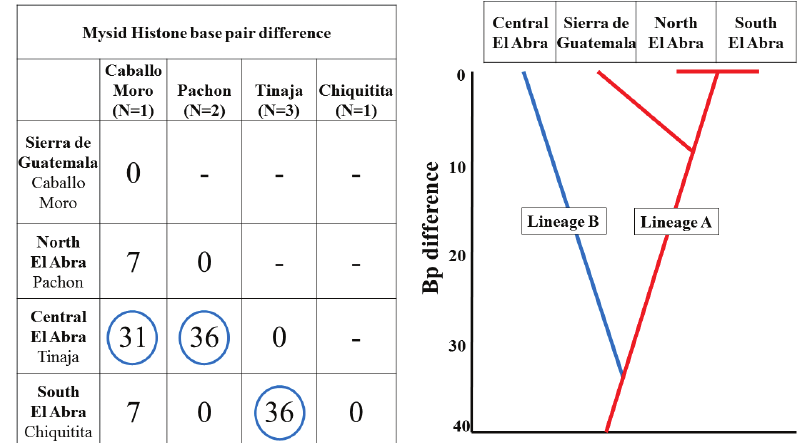
Figure 3. A, Base pair differences of histone 3 sequences between mysid shrimps. Specimens from central Sierra de El Abra (Lineage B) are markedly different from all other populations (Lineage A).